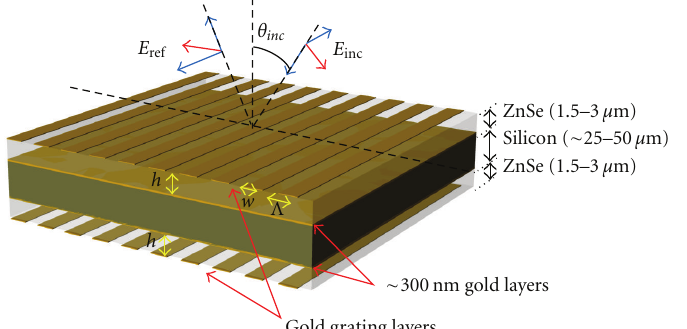
Figure 2: Illustration of our surface plasmon-based IR resonant particles. The gold subwavelength gratings along with cavity resonances produce distinct resonant absorption phenomenon within the LWIR band.